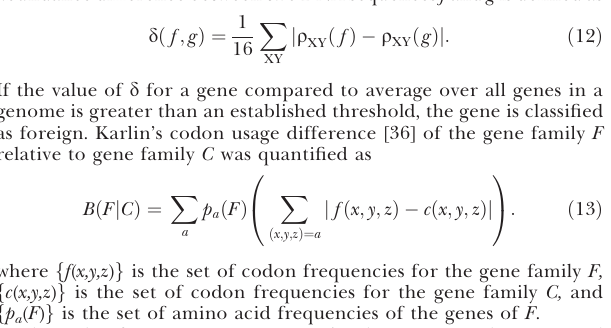
Figure S1. Correspondence Analysis of CUB The first axes—indicating variability in usage among 59 synonymous codons—are plotted for 4,255 E. coli genes (A), 2,141 E. coli genes representing the ‘‘ core ’’ genome (B), and 2,141 genes comprising the artificial E. coli core genome (C). The artificial genome was created from genes clustered by frame-specific DNC. Figure S2. Variability within Genuine and Artificial E. coli Genomes The percent GC of third-codon positions is plotted for 4,255 E. coli genes (A), 2,141 ‘‘ core ’’ E. coli genes (B), and 2,141 genes within the artificial ‘‘ core ’’ E. coli genome (C). The artificial core genome was created from genes clustered by frame-specific DNC; l and r represent the mean and standard deviation of the distribution. Figure S3. Tradeoffs in Error Rates for Several Methods of Gene Detection ArtificialgenomesweregeneratedfromMarkovmodelstrainedoncore genomesextractedusingaK-Ldistancemethod.ComparetoFigure5B. Found at DOI: 10.1371/journal.pcbi.0010056.sg003 (142 KB TIF). Figure S4. Cumulative GC-Skew Plots for Genuine and Artificial E. coli Genomes For each gene, GC skew was calculated as (%G – %C)/(%G þ %C) of third-codon positions, corrected for direction of transcription. Beginning with the first gene in a genome sequence, cumulative skew was obtained as the sum of skew values for the preceding genes. The genuine E. coli genome comprised 4,255 protein-coding genes, whereas the artificial genomes comprised 4,000 genes. Cumulative GC-skew plots are shown for artificial E. coli genomes with and without gene models accounting for strand bias during training. Strand bias is evident as large domains of either G-rich or C-rich genes in the genuine E. coli genome and in the artificial genome with strand identity incorporated into the model. Performance of Combined Parametric Methods for Detecting Atypical Genes in Prokaryotic